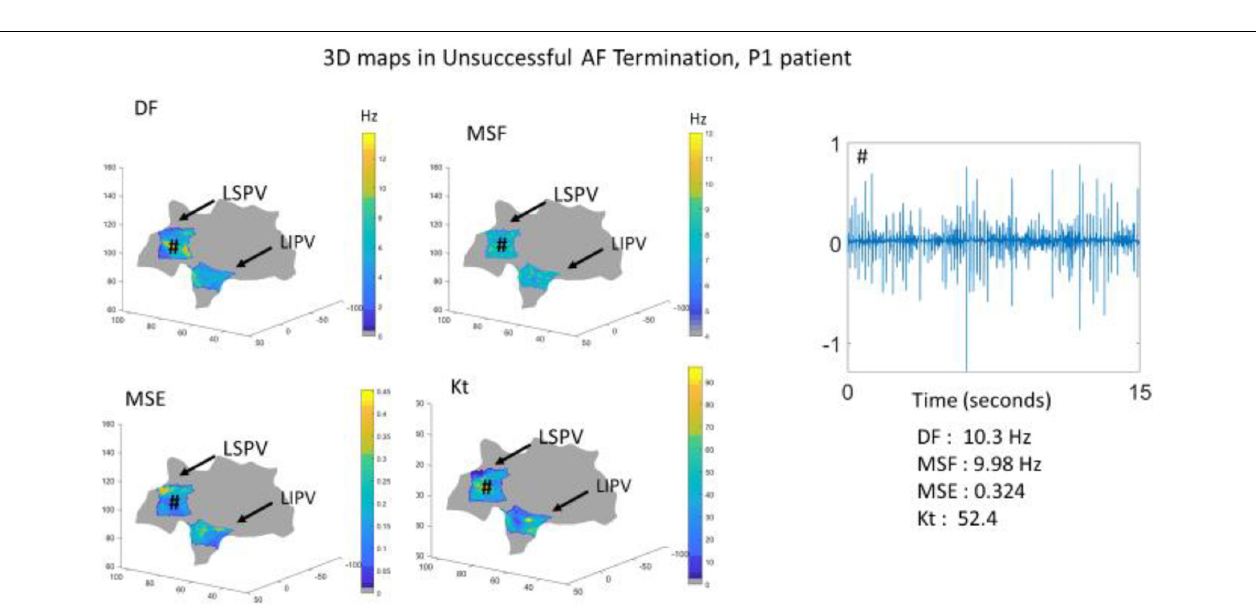
FIGURE 1 | Performance of the different approaches, such as dominant frequency (DF), multiscale frequency (MSF), multiscale entropy (MSE), and kurtosis (Kt), that were applied to the bipolar intracardiac electrogram (BiEGM) analysis from patients with successful ( m = 4) and unsuccessful ( m = 4) atrial fibrillation (AF) termination. Asterisk indicates statistical significance with p < 0.05.